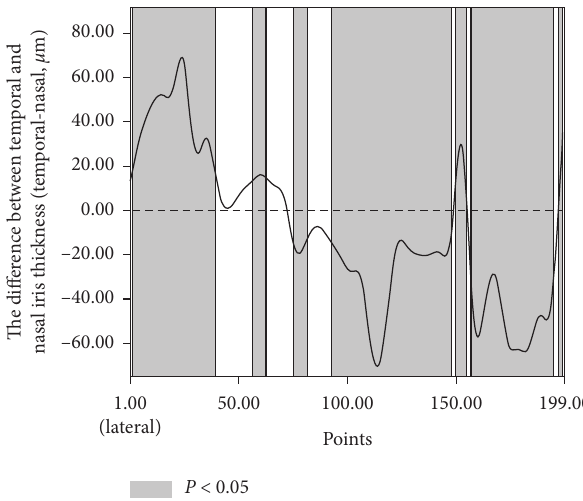
Figure 2: Differences between temporal and nasal iris thicknesses. Filled: the difference was statistically significant ( P <